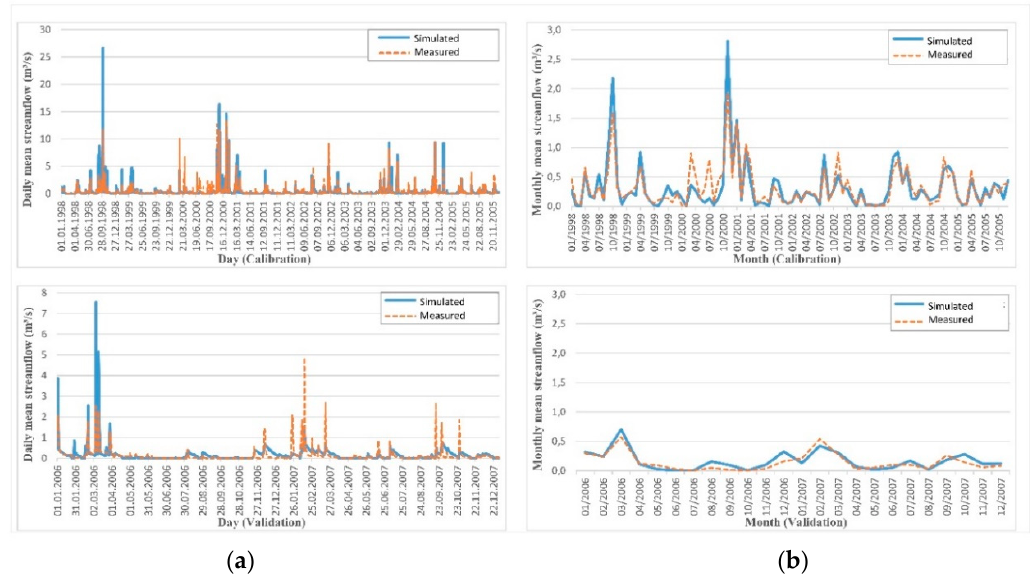
Figure 3. Comparison between the measured and the simulated ( a ) mean daily streamflow (m 3 / s) and ( b ) mean monthly streamflow (m 3 / s) at the Kožbanjšˇcek stream main outflow for the calibration (1998–2005) and validation (2006–2008) periods.